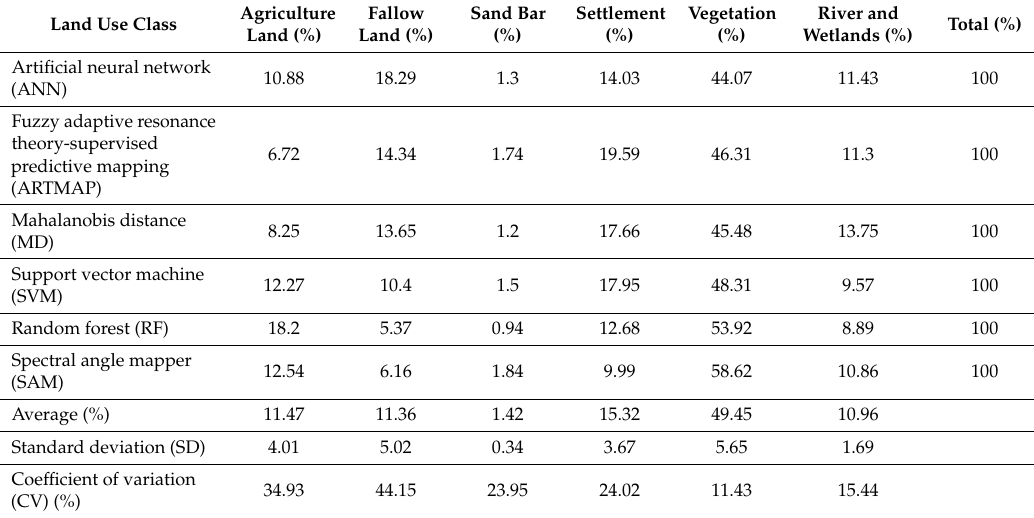
Table 3. Percentage of areal coverage of di ff erent LULC